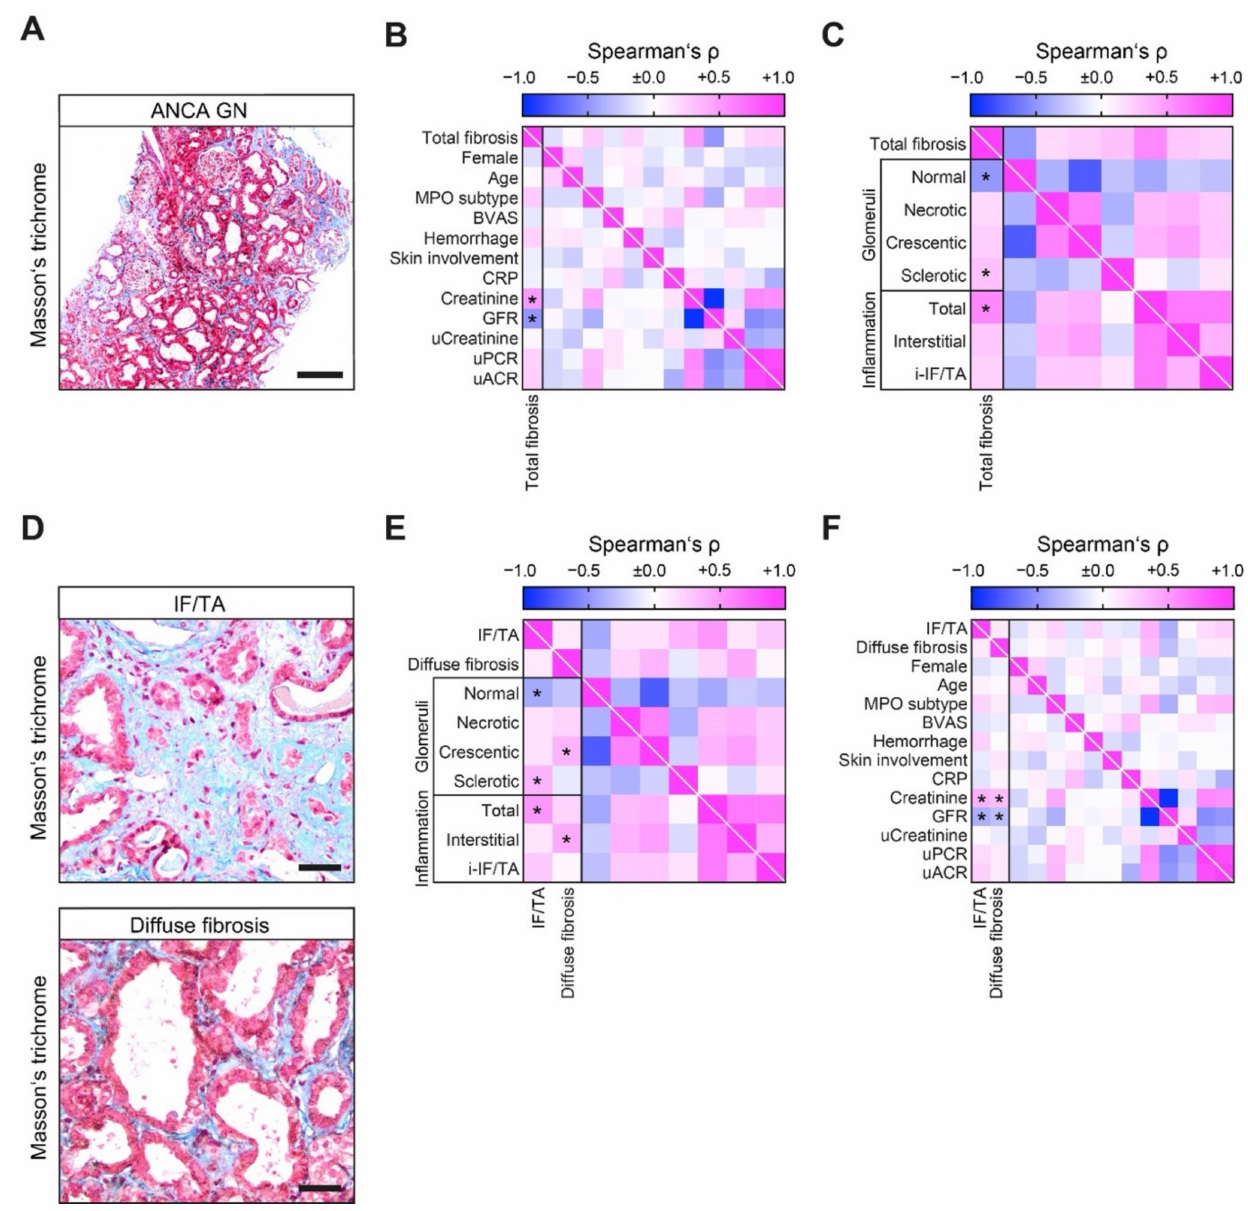
Figure 3. Focal IF/TA and diffuse fibrosis are indicative of injury to distinct renal compartments in ANCA GN. ( A ) Repre- sentative photomicrograph of Masson’s trichrome-stained kidney section in ANCA GN (scale bar: 200 µ m). ( B ) Association between total kidney fibrosis, clinical and laboratory findings in ANCA GN are shown by heatmap reflecting mean values of Spearman’s ρ , asterisks indicate p < 0.05. ( C ) Association between total kidney fibrosis, glomerular and inflammatory findings in ANCA GN are shown by heatmap reflecting mean values of Spearman’s ρ , asterisks indicate p < 0.05. ( D ) Repre- sentative photomicrograph of Masson’s trichrome-stained kidney section in ANCA GN with focal IF/TA (upper panel) and diffuse fibrosis (lower panel) are shown (scale bars: 40 µ m). ( E ) Association between focal IF/TA and diffuse fibrosis with glomerular and inflammatory findings are illustrated by heatmap reflecting mean values of Spearman’s ρ , asterisks indicate p < 0.05. ( F ) Association between focal IF/TA and diffuse fibrosis with clinical and laboratory findings in ANCA GN are shown by heatmap reflecting mean values of Spearman’s ρ , asterisks indicate p < 0.05. Abbreviations: ANCA GN—antineutrophil cytoplasmic antibody glomerulonephritis; BVAS—Birmingham Vasculitis Activity Score; CRP—c- reactive protein; GFR—glomerular filtration rate; IF/TA—interstitial fibrosis/tubular atrophy; IQR—interquartile range; MPO—myeloperoxidase; uACR—urine albumin/creatinine ration; uPCR—urine protein/creatinine